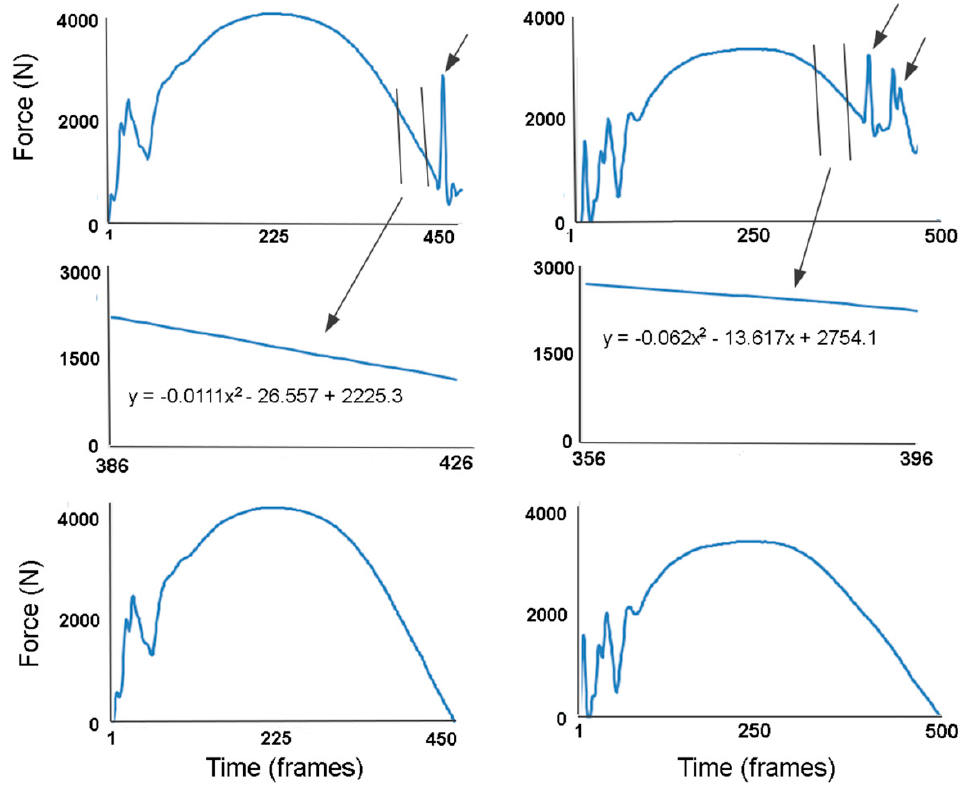
Figure 1. The estimation of vertical ground reaction force during the periods of stance overlap for two stance phases: ( A ) on the left; ( B ) on the right. The upper graph shows the vertical ground reaction force-time graph with impact peaks (indicated with short arrows) in terminal stance, which is associated with the contact of a second hoof on the same force plate. The vertical lines show the part of the trace used to develop a second order polynomial equation shown in the middle graph. The polynomial was used to estimate the terminal part of the vertical ground reaction force trace. The lower graph shows the estimated vertical force-time profiles. Each polynomial was unique and was determined using an iterative process in which the selection window of frames was adjusted until a best fit unloading slope with a threshold smaller than ± 100 N at lift off was found.